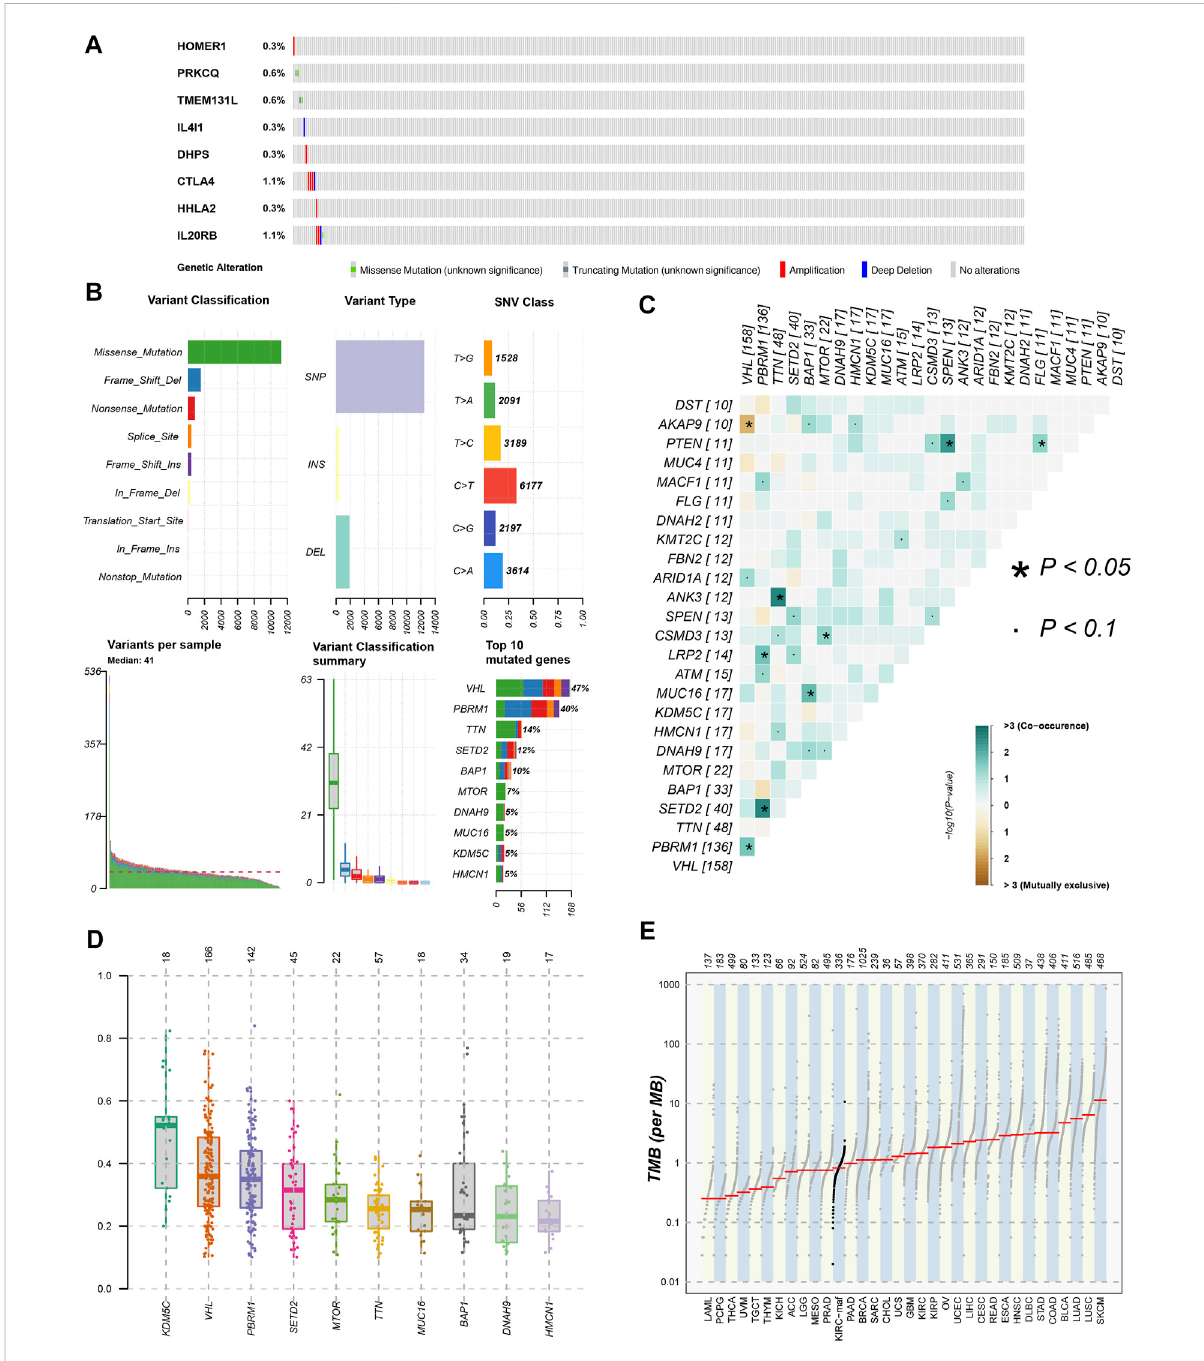
FIGURE 10 Gene mutation analysis of ccRCC patients. (A) The mutation of 8 modeling TRGs obtained from the cBioPortal database; (B) the mutation landscape of ccRCC patients in the TCGA database; (C) genes with mutually exclusive mutation or simultaneous mutation; (D) the Variant Allele Frequencies (VAF) boxplot of mutated genes; (E) the comparison of TMB among ccRCC and other tumors in TCGA